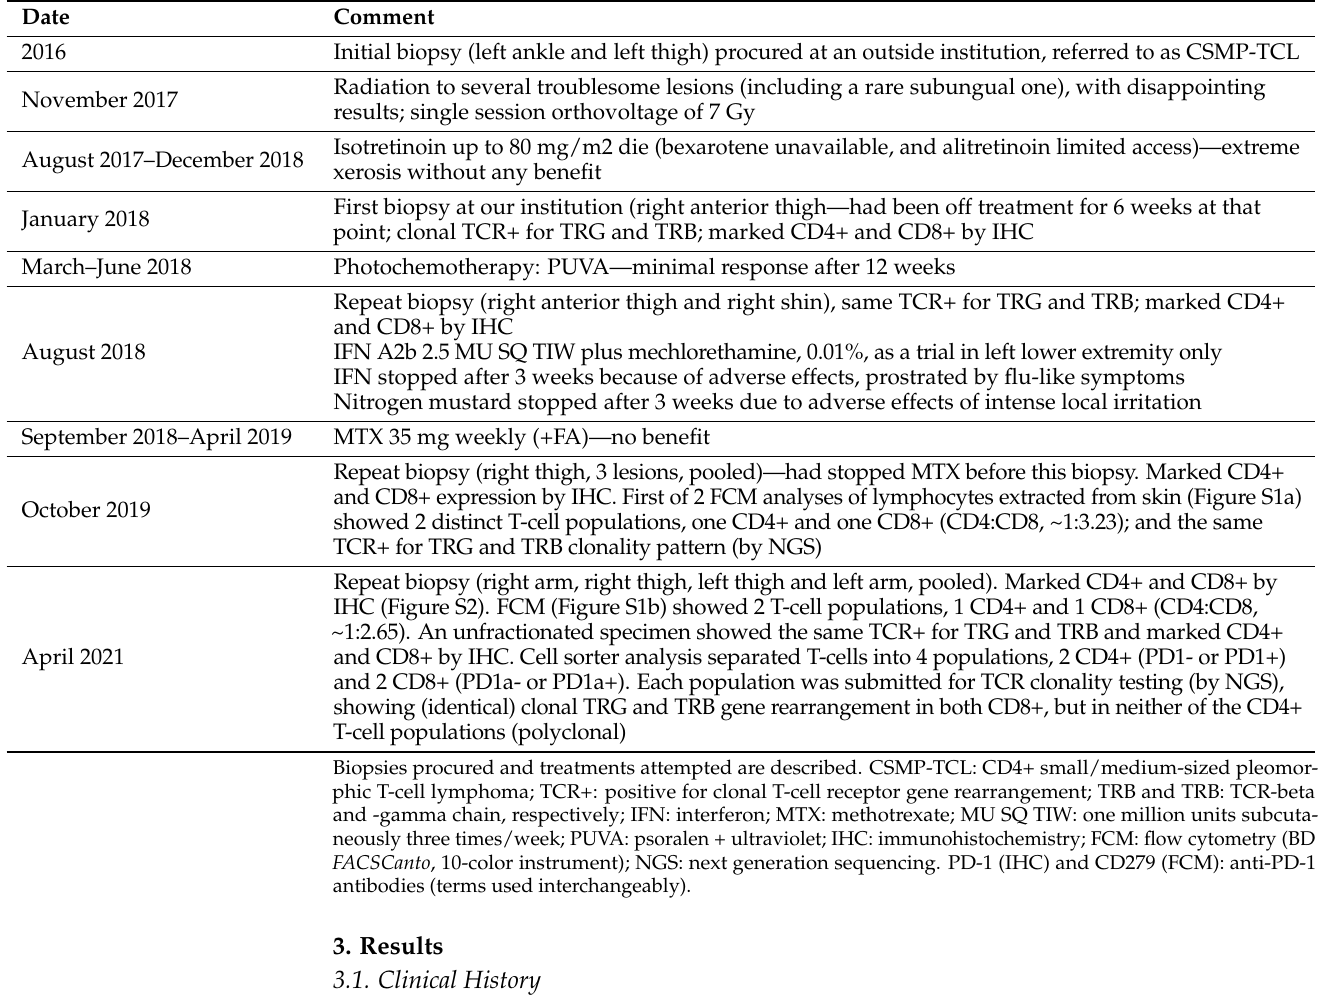
Table 1. Biopsies procured and Treatments